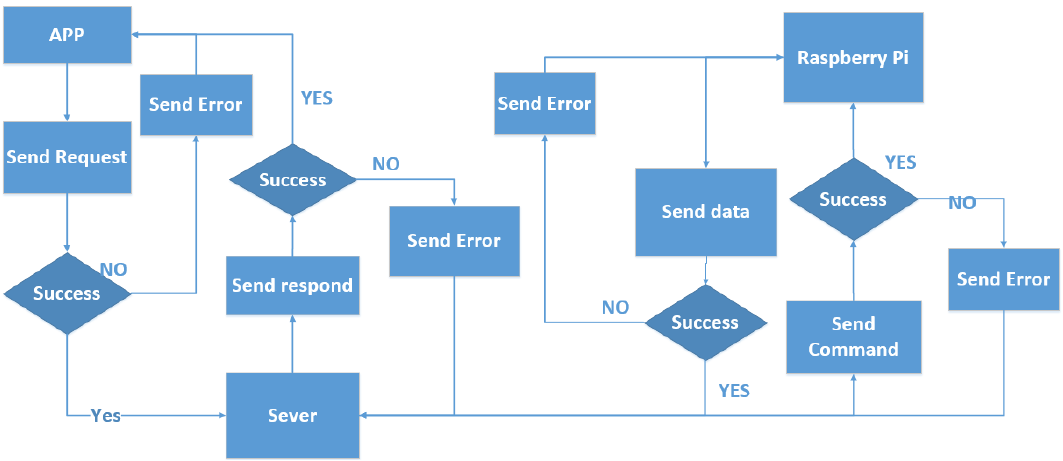
Figure 16. Synchronization flowchart.